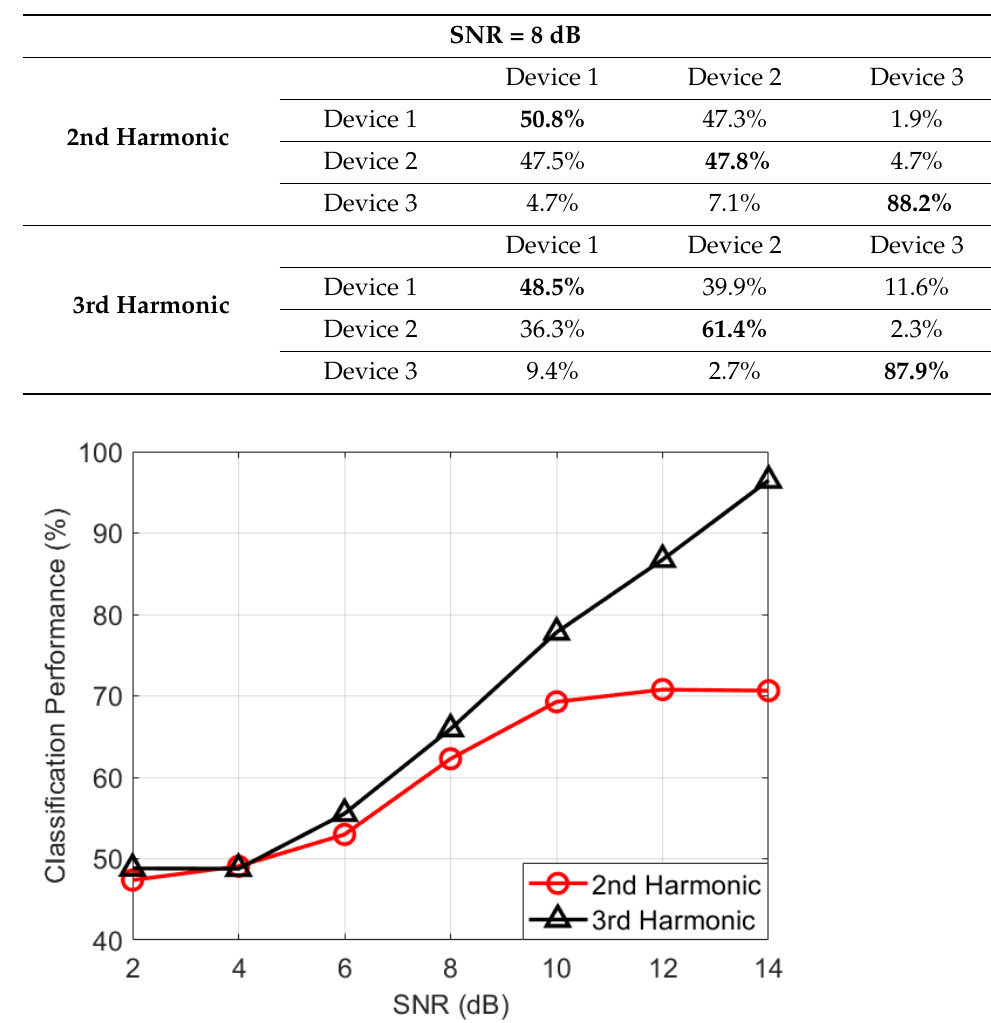
Figure 17. Classification performance of the harmonics in Fourier feature space for varying SNR values.